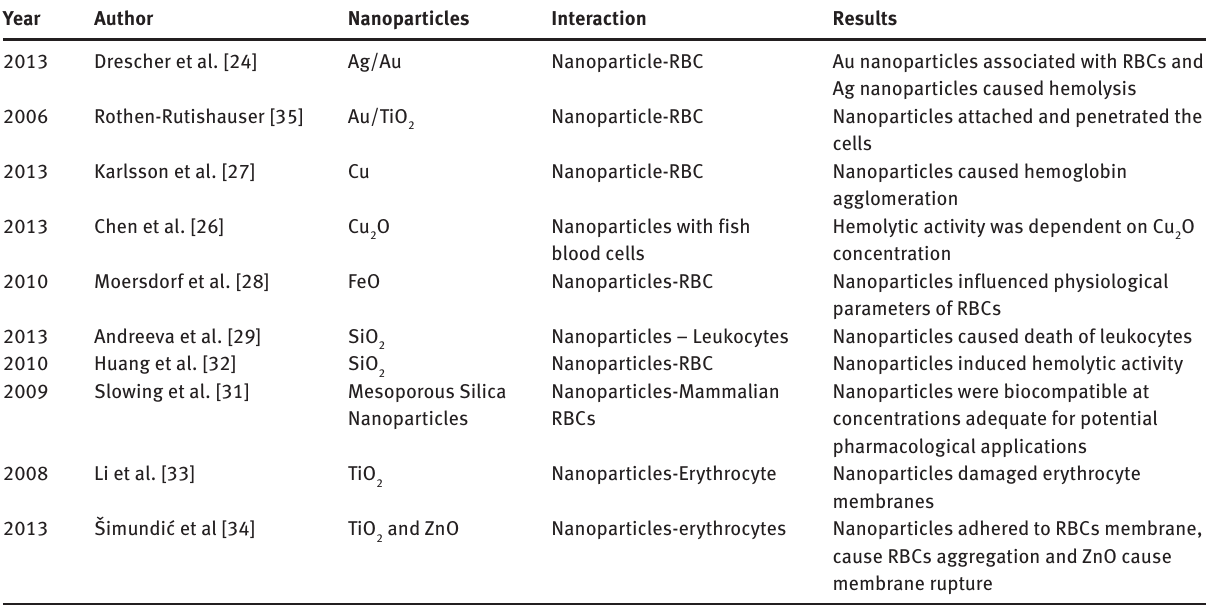
Table 2: Journal reviews on interaction of different NPs with blood